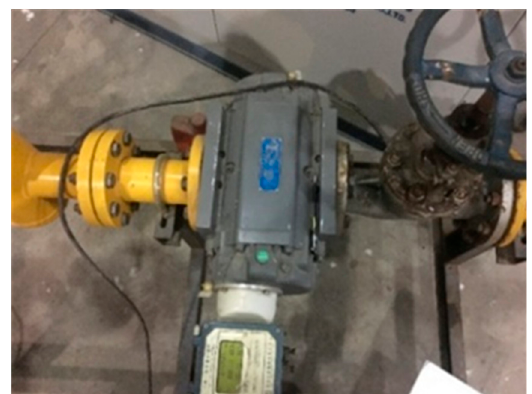
Figure 7. Pressure gauge.